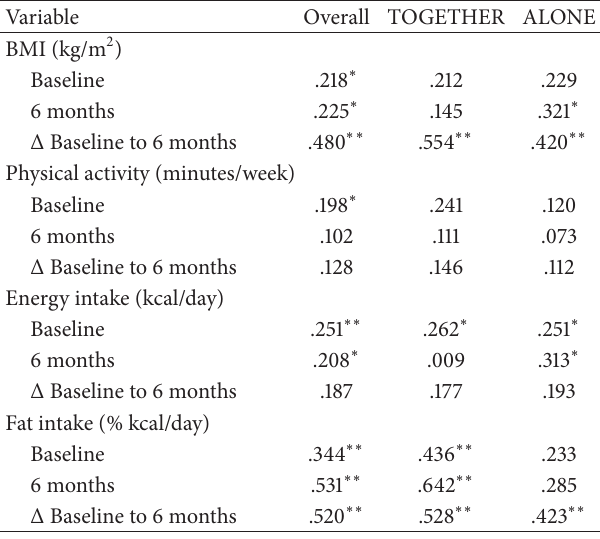
Table 3: Correlations between spouses’ behaviors by treatment group at baseline, 6 months, and change over 6